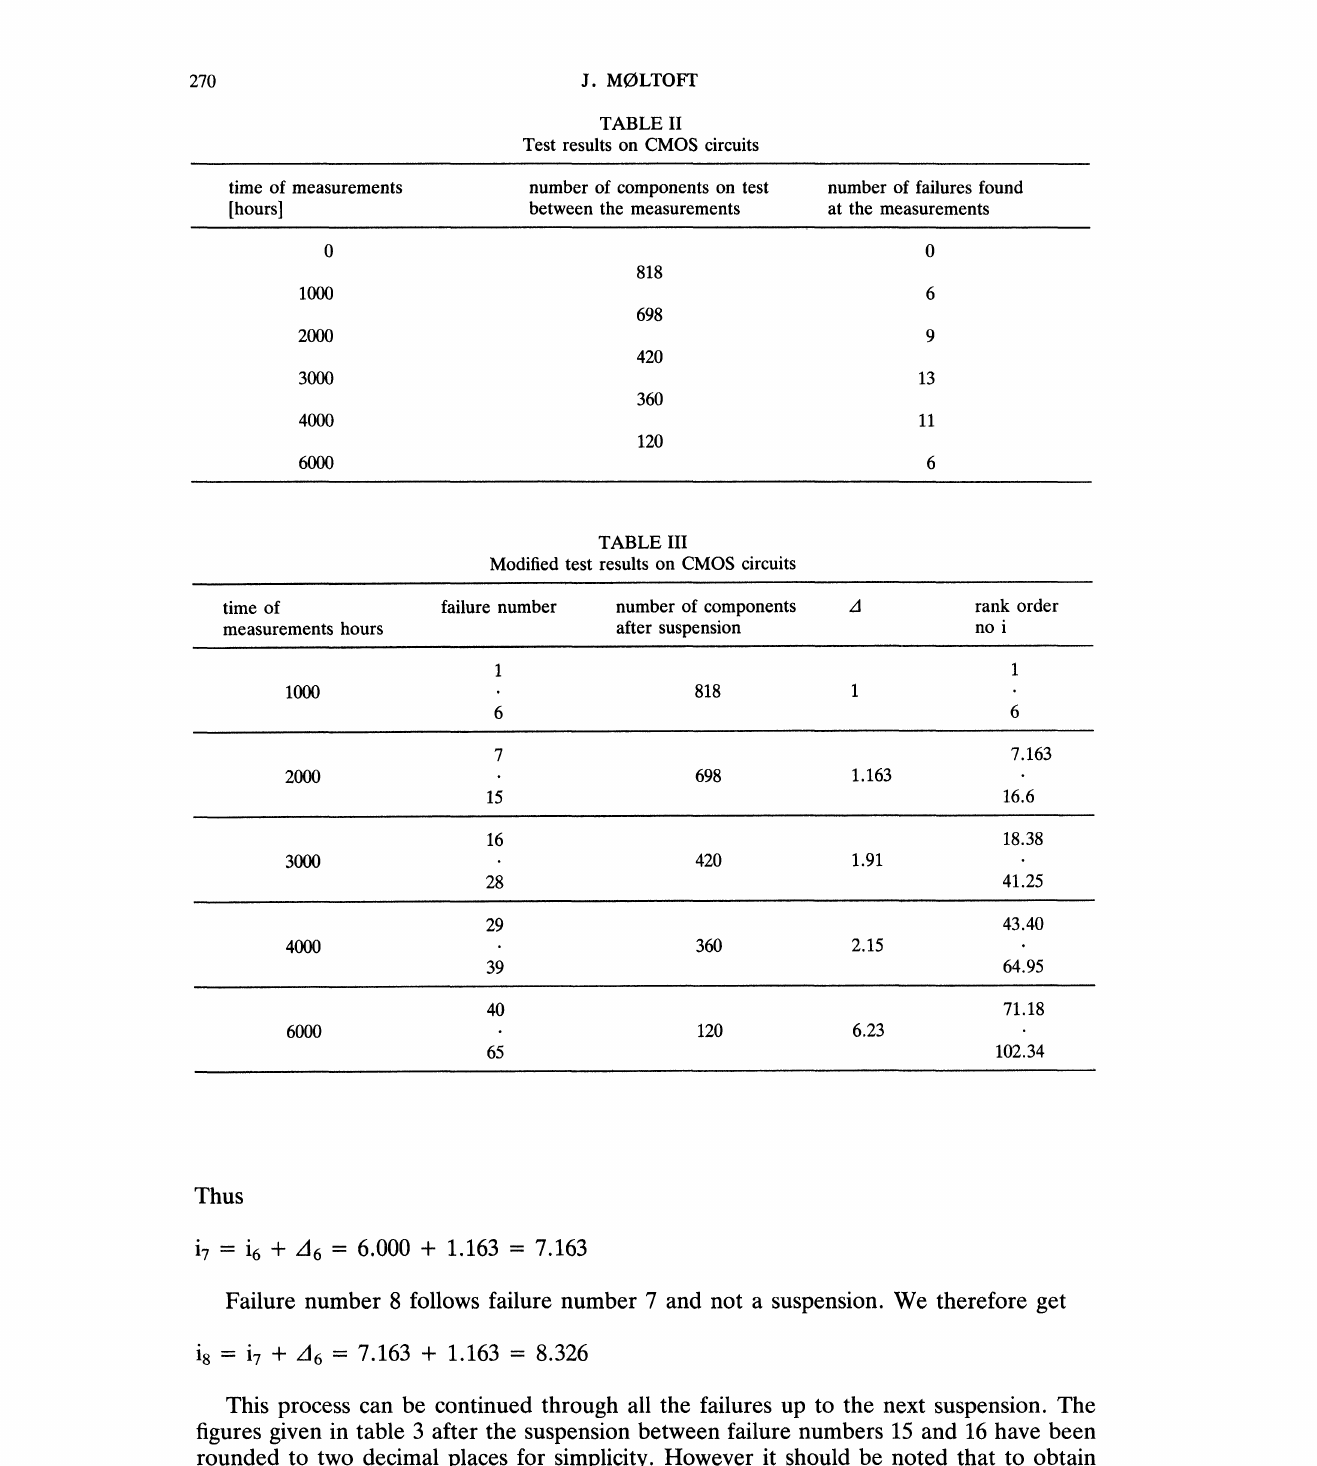
TABLE III Modified test results on CMOS